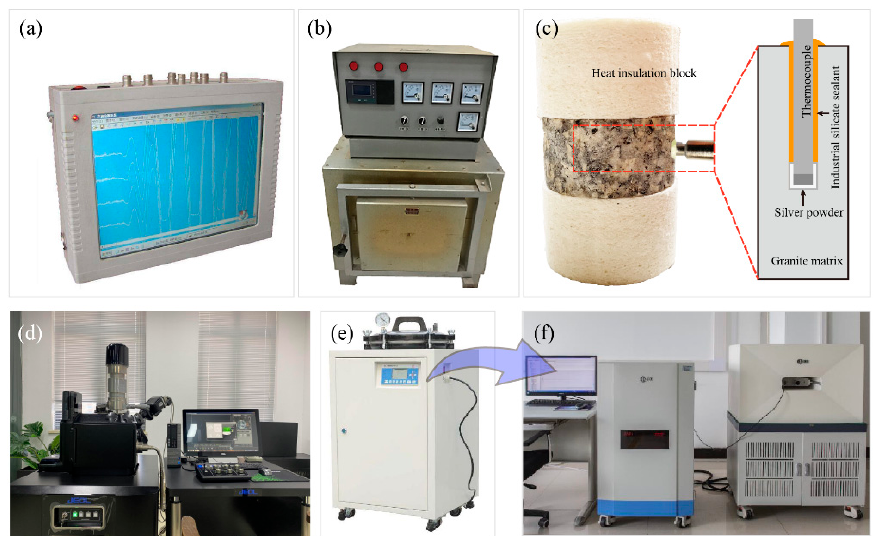
Figure 3. Schematic diagram of experimental procedure and laboratory equipment: ( a ) ultrasonic parameter detector, ( b ) muffle furnace, ( c ) the specimen fixed with heat insulation blocks, ( d ) scanning electron microscope, ( e ) vacuum saturated machine, ( f ) nuclear magnetic resonance testing machine.